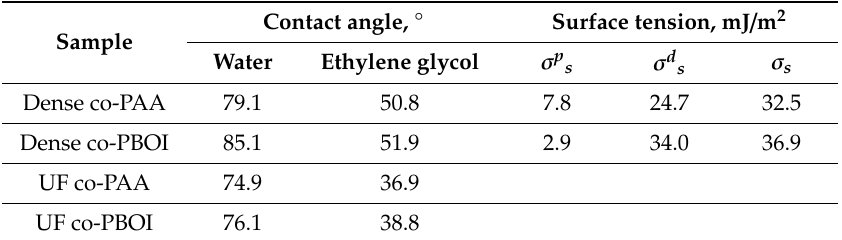
Table 3. Contact angles and surface tension of co-PAA and co-PBOI